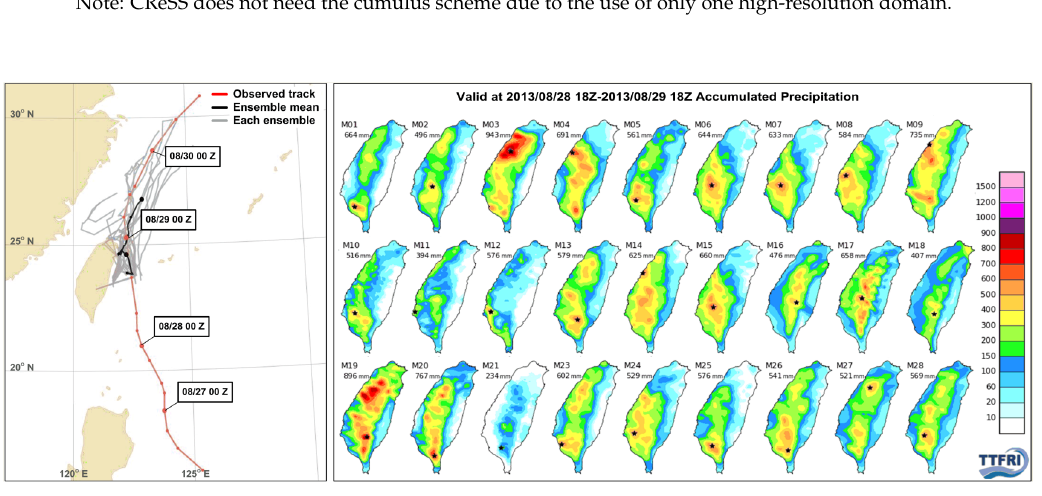
Figure 1. An example of ensemble 24-h typhoon track forecasts and 24-h rainfall forecasts (28 August 2013–29 August 2013) of